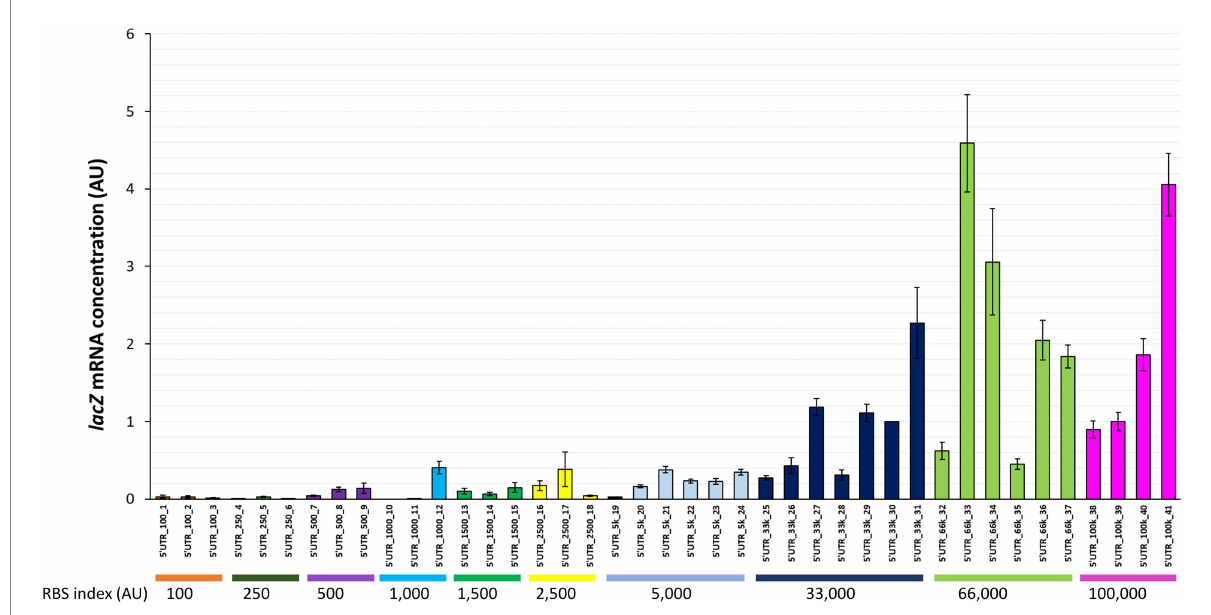
FIGURE 2 lacZ mRNA concentrations associated with 41 synthetic 5’UTRs ordered by RBS index. The lacZ mRNA concentration measured in each strain is reported as a fold change relative to the reference strain (5’UTR_33k_30). Error bars represent standard deviations (n = 3).